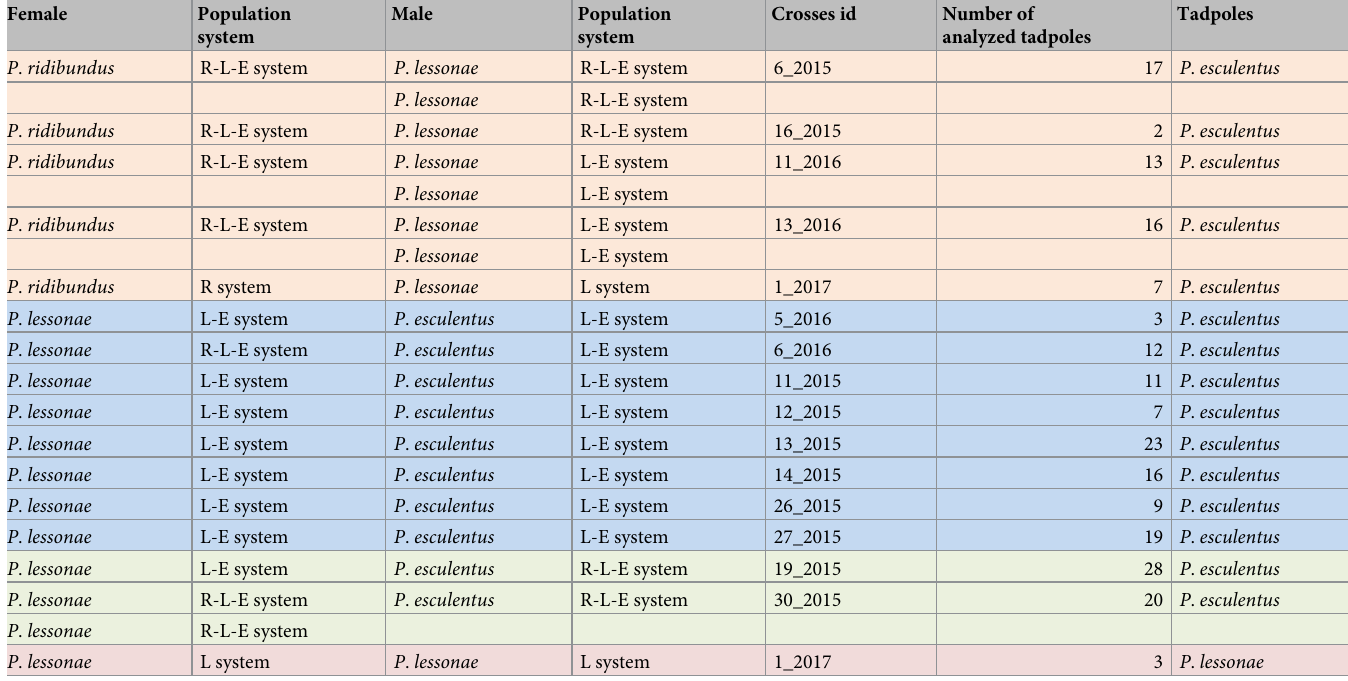
Table 1. Results of crossing P . ridibundus with P . lessonae (marked orange), P . lessonae individuals with each other (marked red) and diploid hybrids from L-E (marked blue) and R-L-E (marked green)